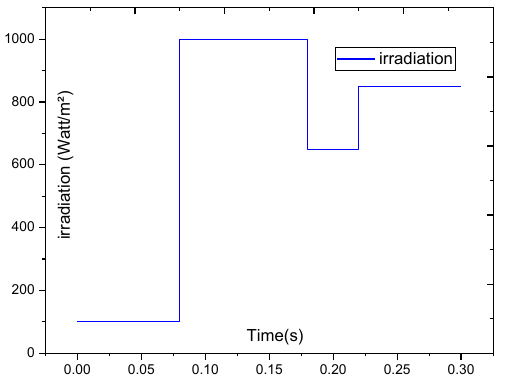
Figure 3: Irradiation profile used in